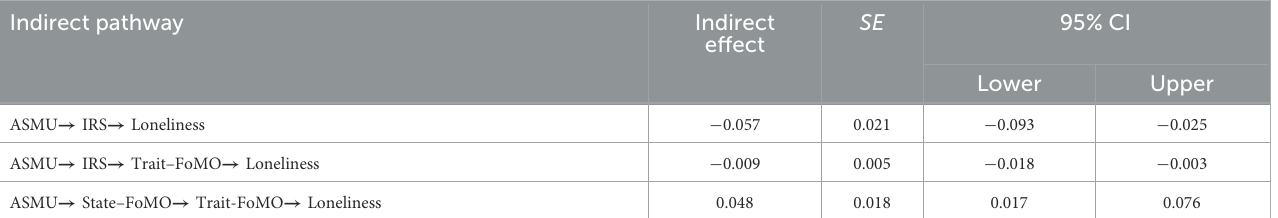
TABLE 2 Standardized indirect effects and their 95% confidence intervals. Indirect